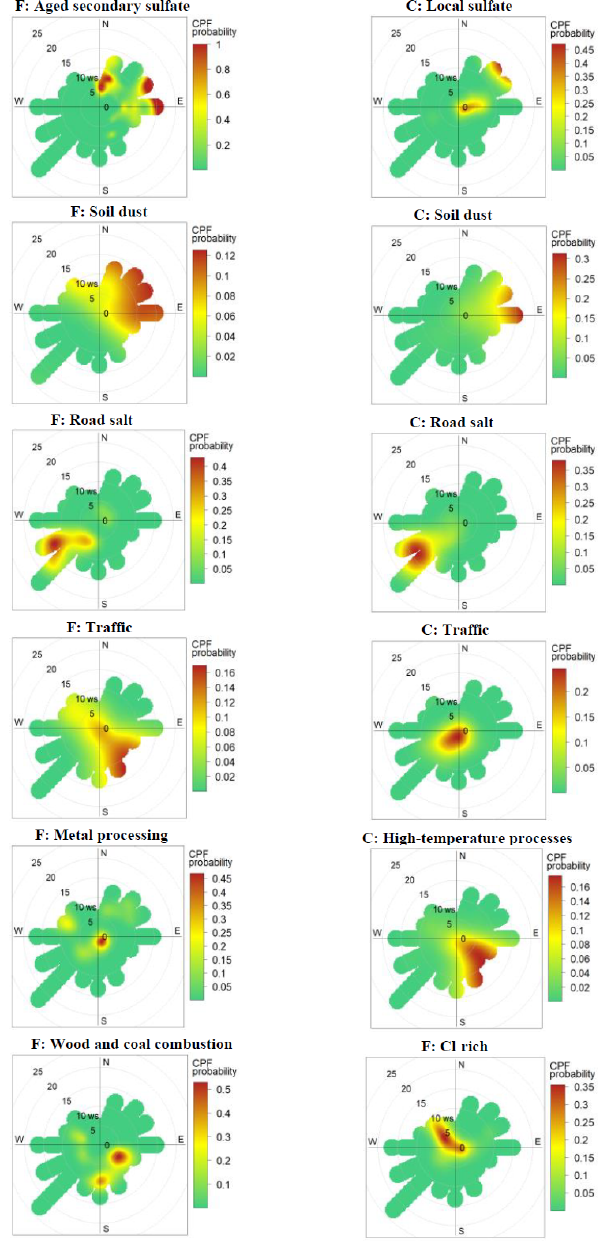
Figure 6. Conditional probability function (CPF) analysis (at the 90th percentile) of the PMF sources identified in the fine (F) and coarse (C) fractions. Wind speed (ws) is expressed in kilometers per hour (hereafter kmh − 1